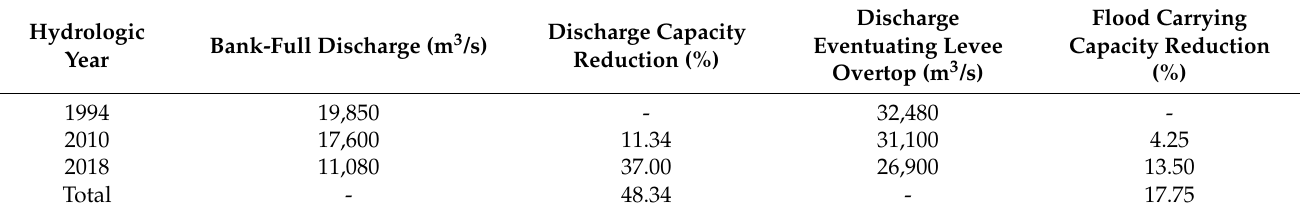
Table 3. HEC-RAS 1D-model unsteady flow simulations results for bank-full discharge and discharge eventuating levee overtop.